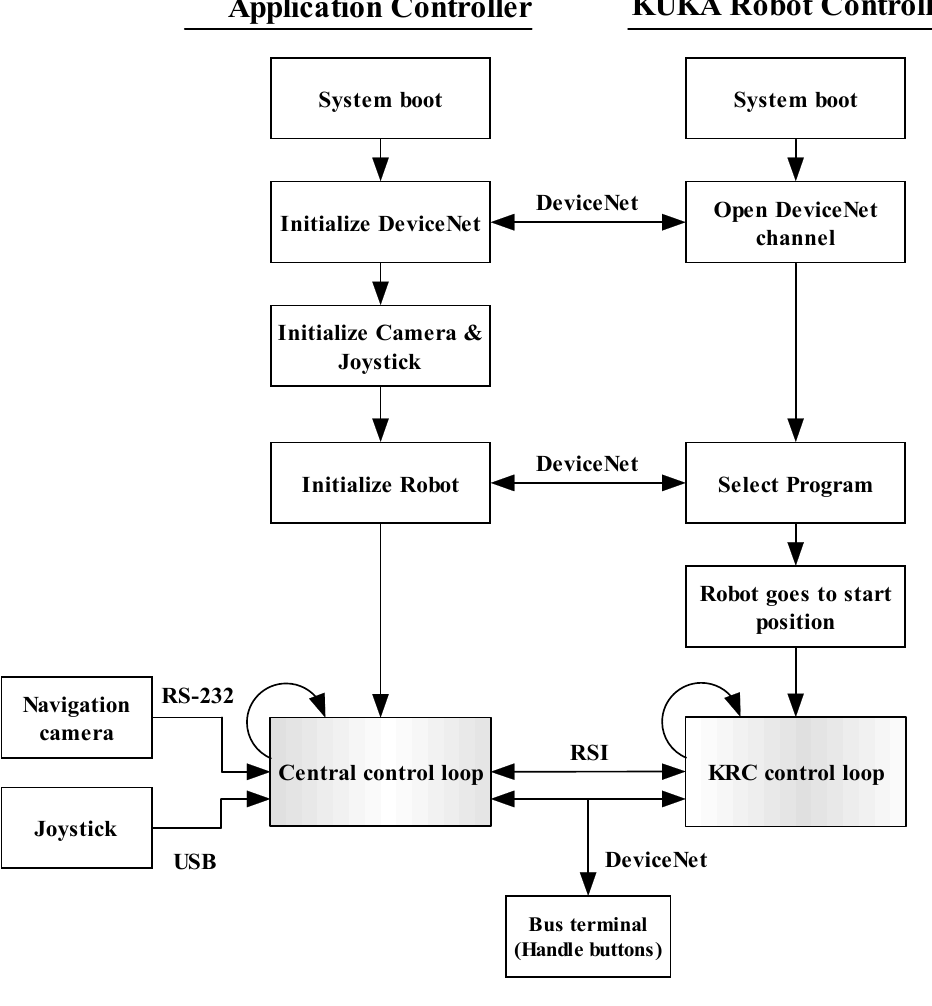
Figure 6. During initialization, all the channels necessary to make the application controller communicate with the main components of the system are opened. Then, the application controller and the KRC interchange information via RSI in order to control the robot motion.